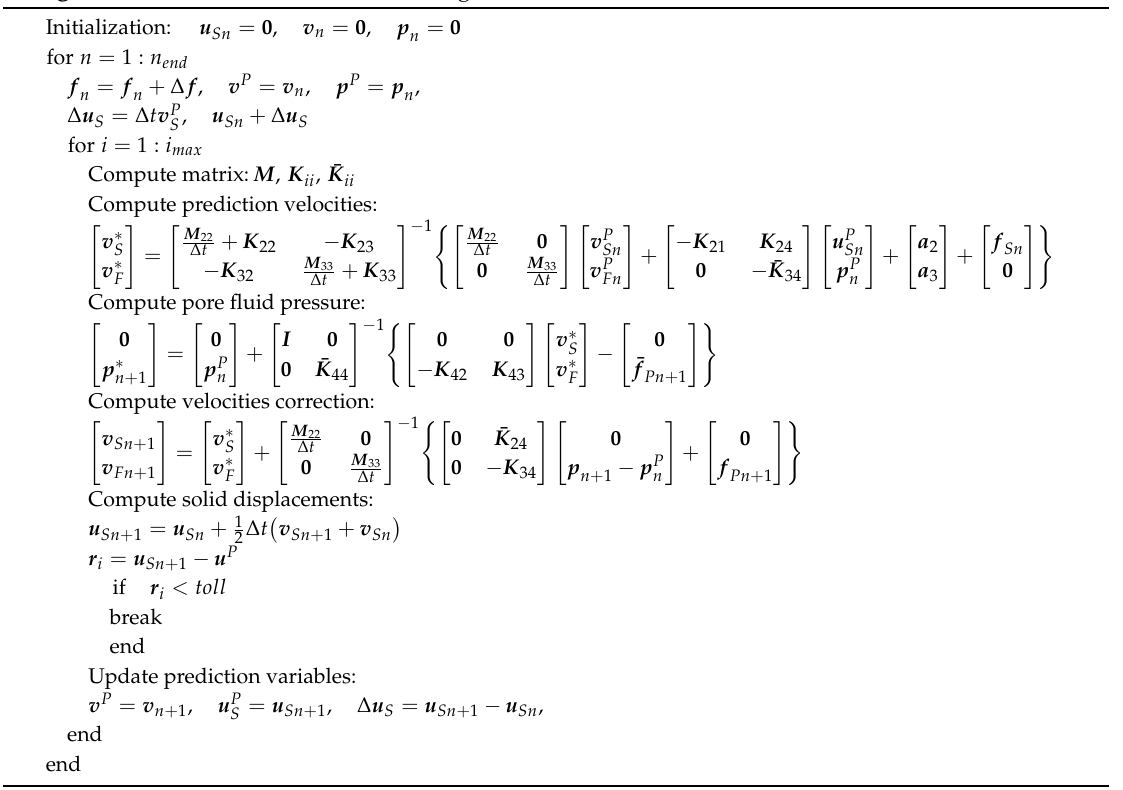
Algorithm 2: Prediction/Correction